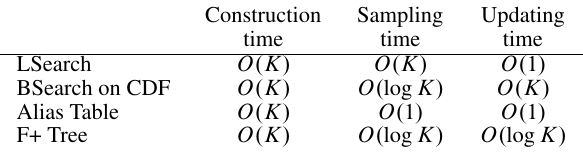
Table 1 Comparison of multinomial samplers. K denotes the multinomial dimension (here, the number of topics). Construction